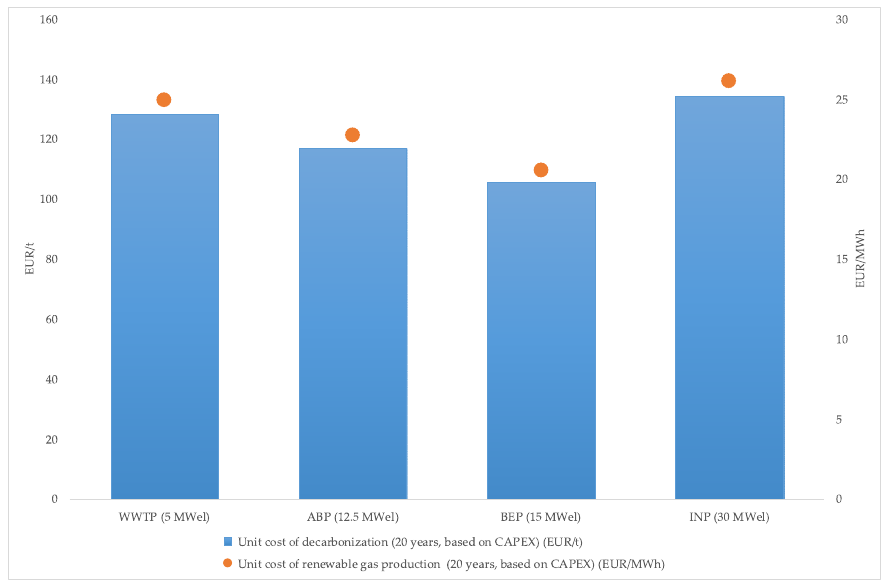
Figure 3. Unit capital cost of decarbonization and renewable gas production (as a prerequisite of seasonal energy storage) of large-scale P2M plants at different sites during their operation (2025 – 2045).